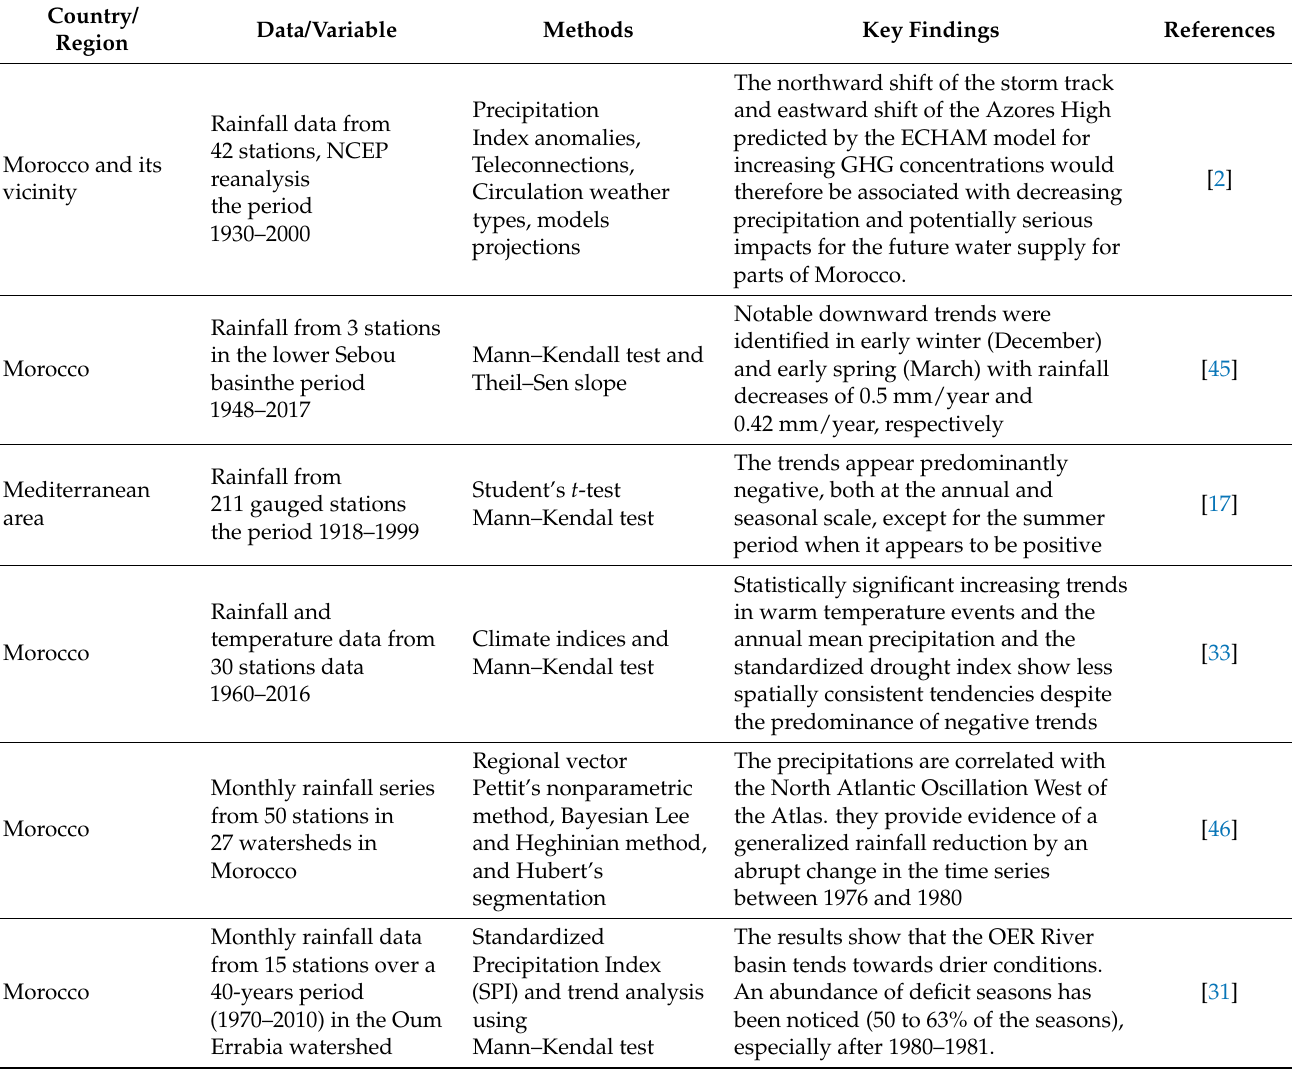
Table 4. Different studies using trend analysis methods compared to our